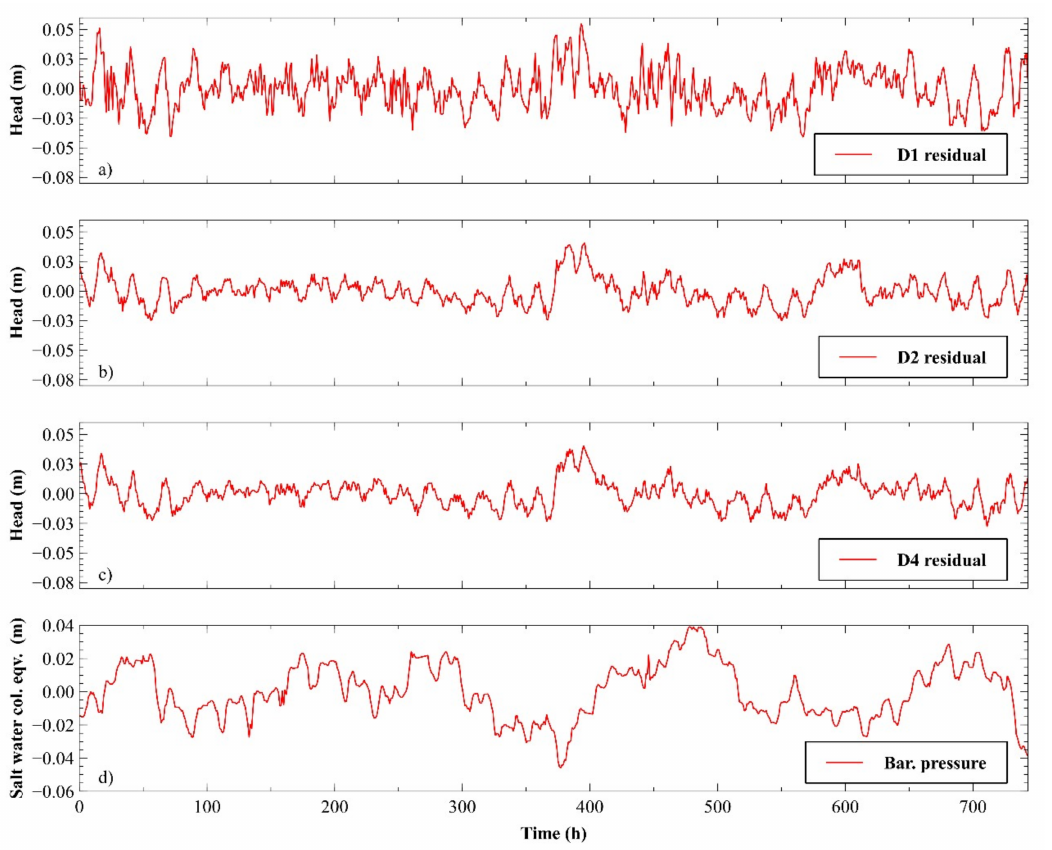
Figure 6. ( a ) D1 piezometric head residual; ( b ) D2 piezometric head residual; ( c ) D4 piezometric head residual; ( d ) detrended barometric pressure corresponding to the period of 1 August to 31 August